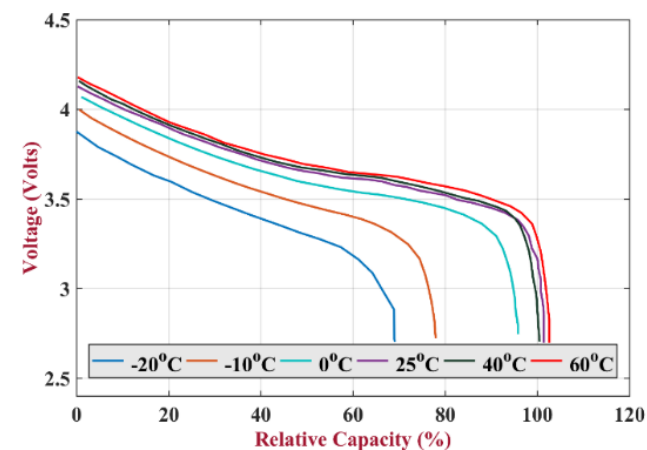
Figure 29. Graphical demonstration of voltage versus relative capacity of a typical Li-Po cell at different temperatures [101].